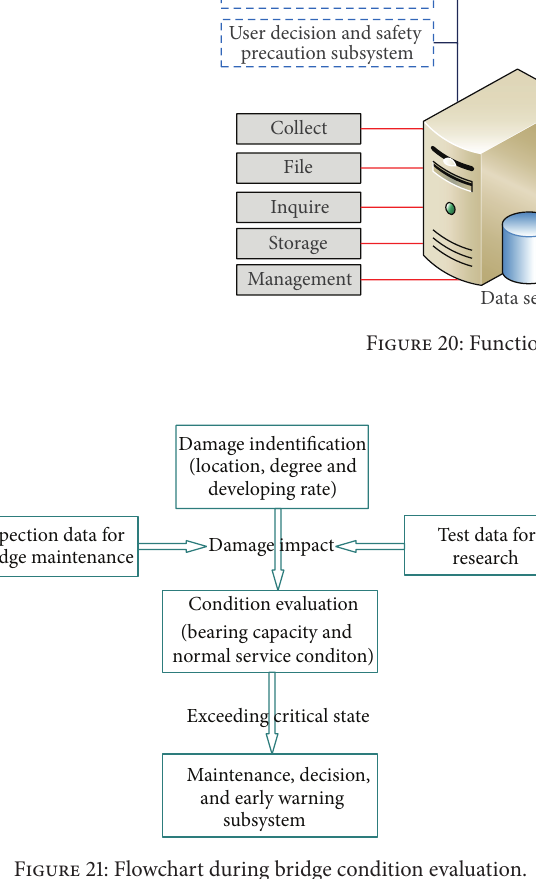
Figure 21: Flowchart during bridge condition